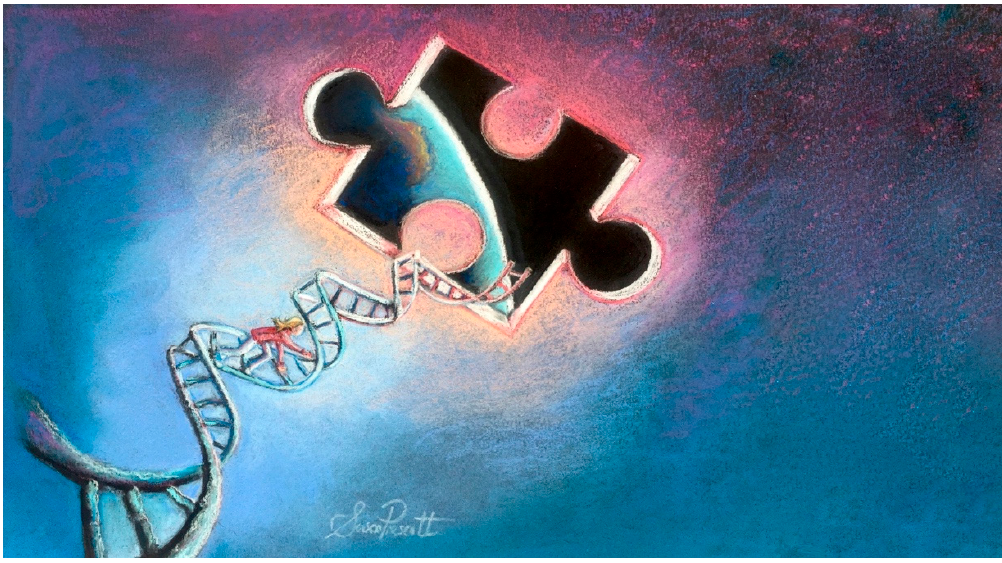
Figure 1. The ‘omics’ revolution is making planetary health personal.